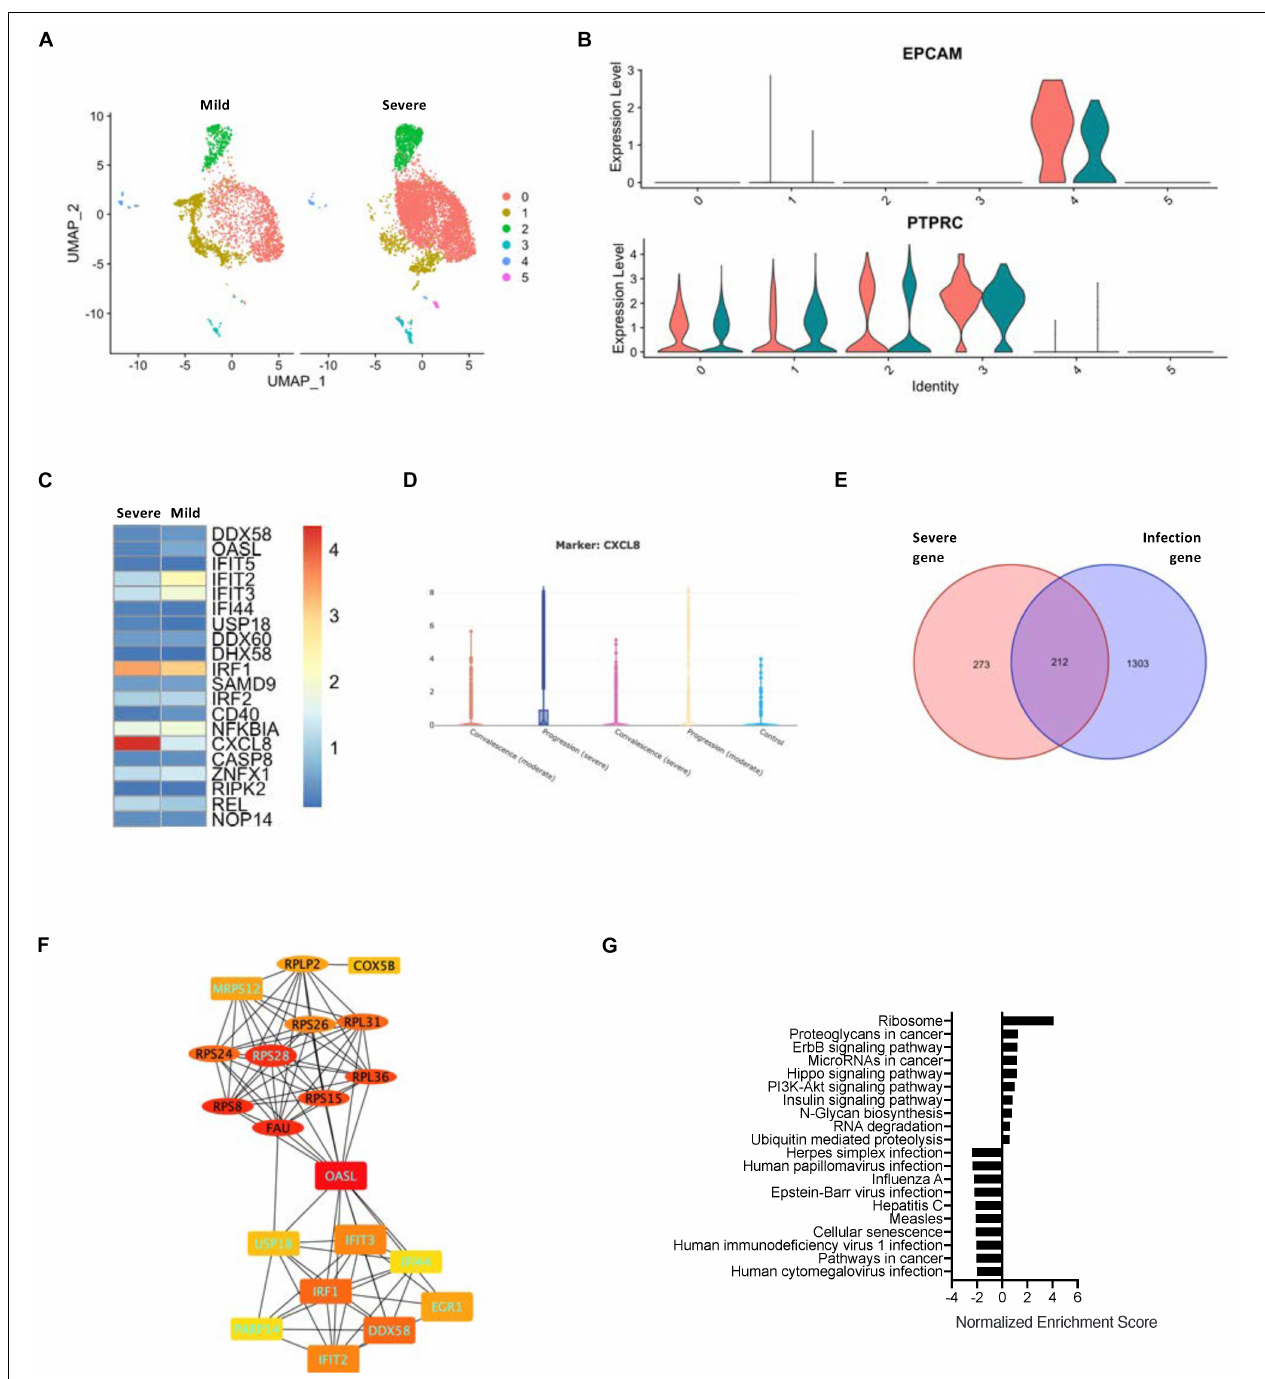
FIGURE 3 | Relationship between SARS-CoV-2 infection in the epithelial cells and severity of COVID-19. (A) A UMAP diagram showing an overlay of the main cell types of the severe and mild ARDS BALF samples. (B) Violin plots to annotate the leukocytes and epithelial cells in the severe and mild ARDS BALF samples. (C) A heat map demonstrating the expression levels of the COVID-19-related PPI hub genes in the severe and mild ARDS BALF samples. (D) Violin plots showing the expression of CXCL8 in the severe disease progression group. (E) A Venn diagram highlighting the intersection between COVID-19–related infection-correlated genes and severe ARDS-related genes. (F) The PPI network demonstrating the shared hub gene signatures between COVID-19–related infection-correlated genes and the severe ARDS-related genes. The oval structures indicate the upregulated genes, and the rectangles indicate the downregulated genes in the severe ARDS cases. Genes labeled with light blue text are positively correlated with SARS-CoV-2 infection. (G) A GSEA summary plot of enriched KEGG signaling for the shared gene signature of COVID-19–related infection-correlated genes and the severe ARDS-related genes.